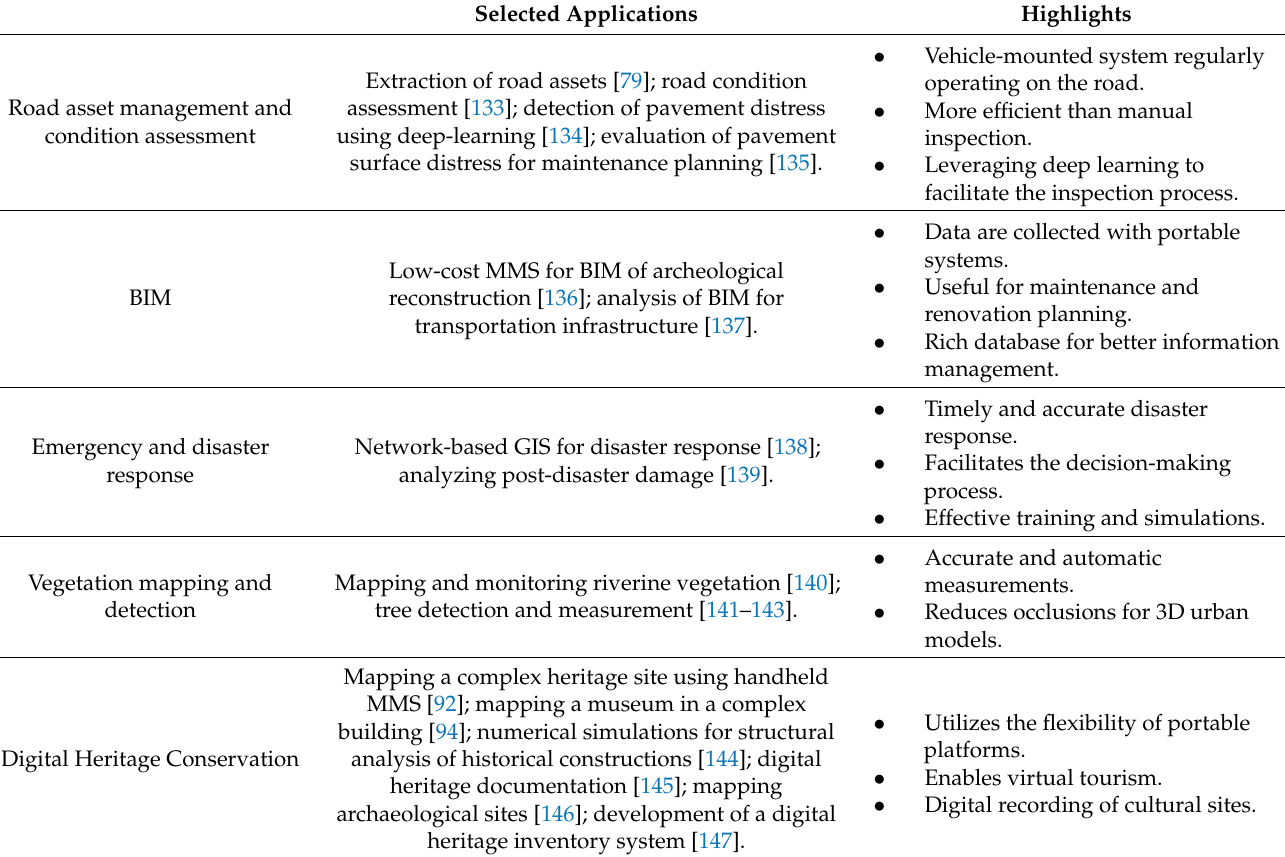
Table 5. An overview of the selected mobile mapping